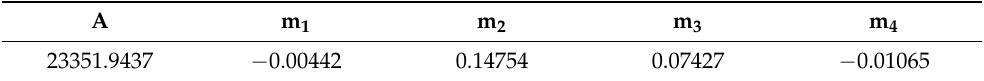
Table 2. X12 steel Hansel–Spittel constitutive model